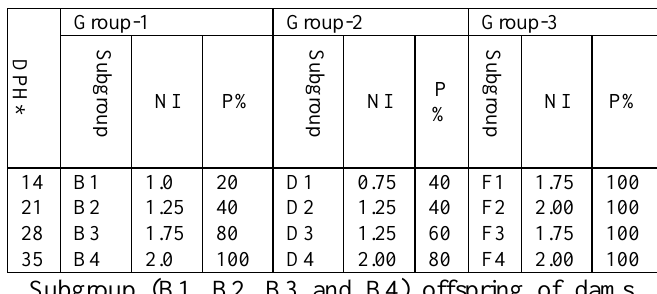
Table 5: NI and protection% in squabs of vaccinated and non-vaccinated dams and vaccinated with TC-PPV at different